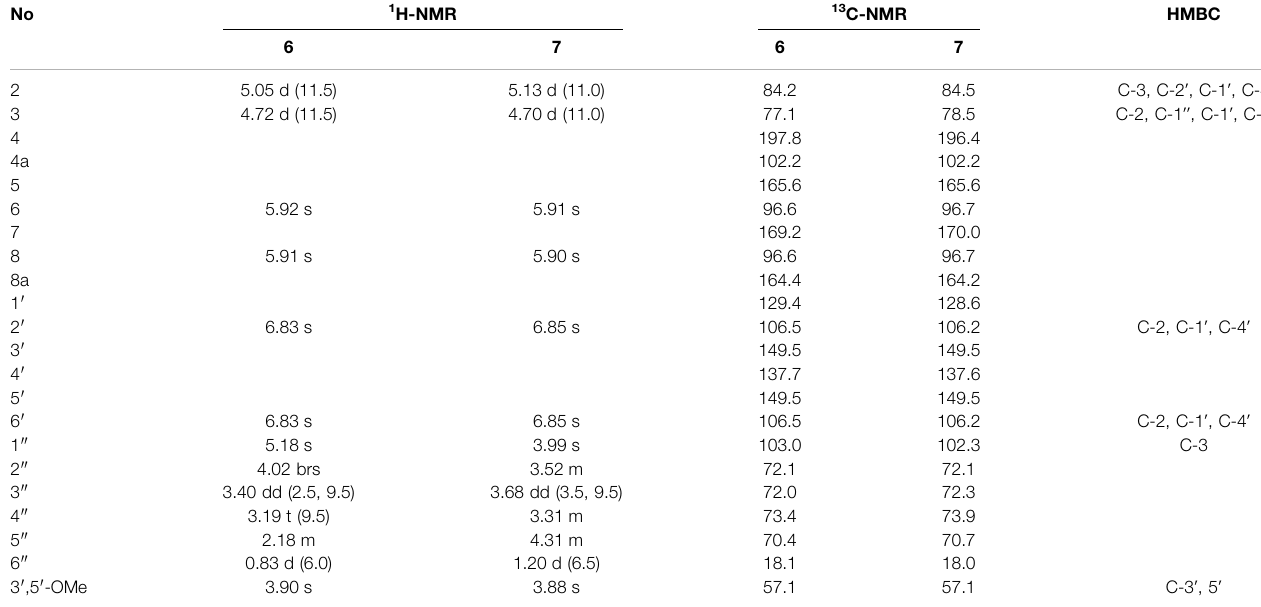
TABLE 2 | 1 H NMR, 13 C NMR, and HMBC data of compounds 6-7 in CD 3 OD ( δ in ppm, J in Hz). No